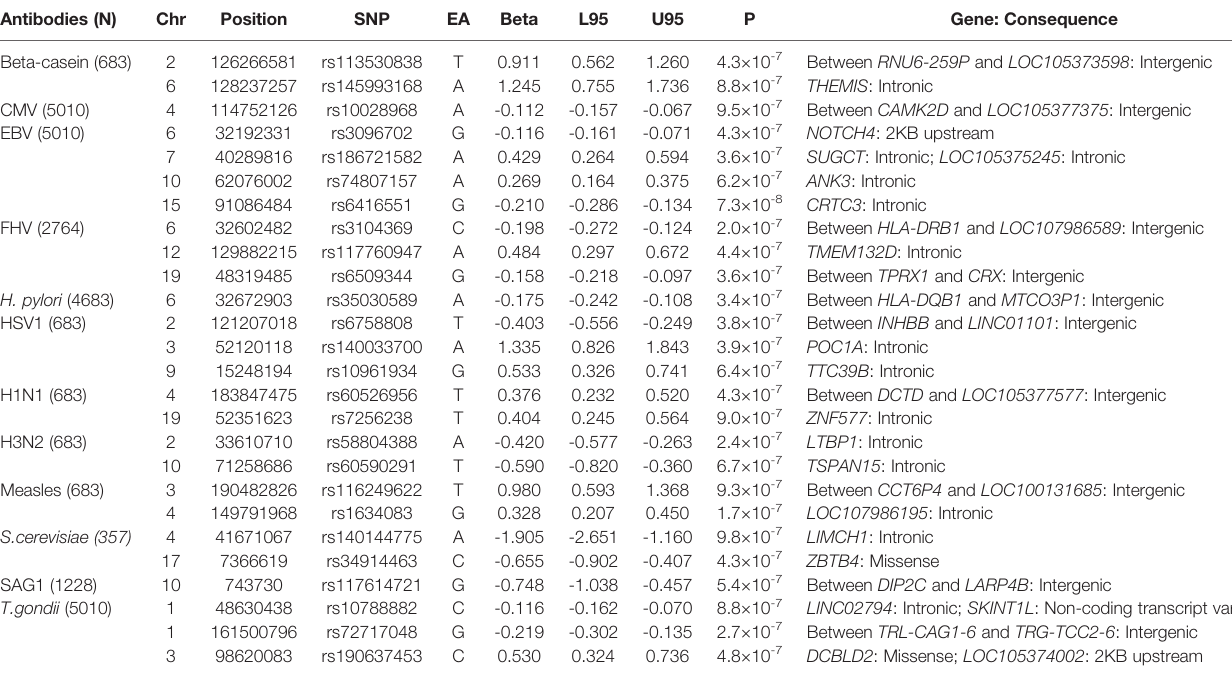
TABLE 3 | Suggestive SNPs with P < 1×10 -6 in measured in the ALSPAC seven-year clinic. Antibodies (N)